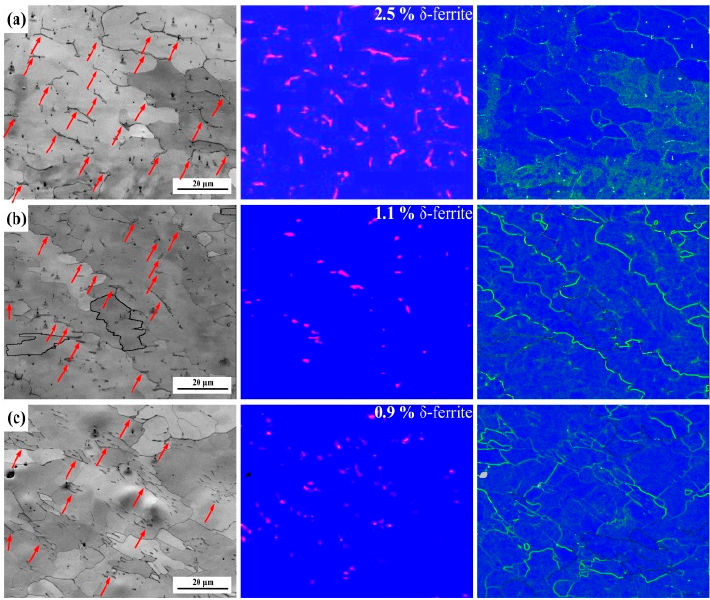
Figure 15. Contrast maps, phase maps, and KAM maps of 1670-14 at di ff erent places: ( a ) top, ( b ) middle, and ( c ) bottom.